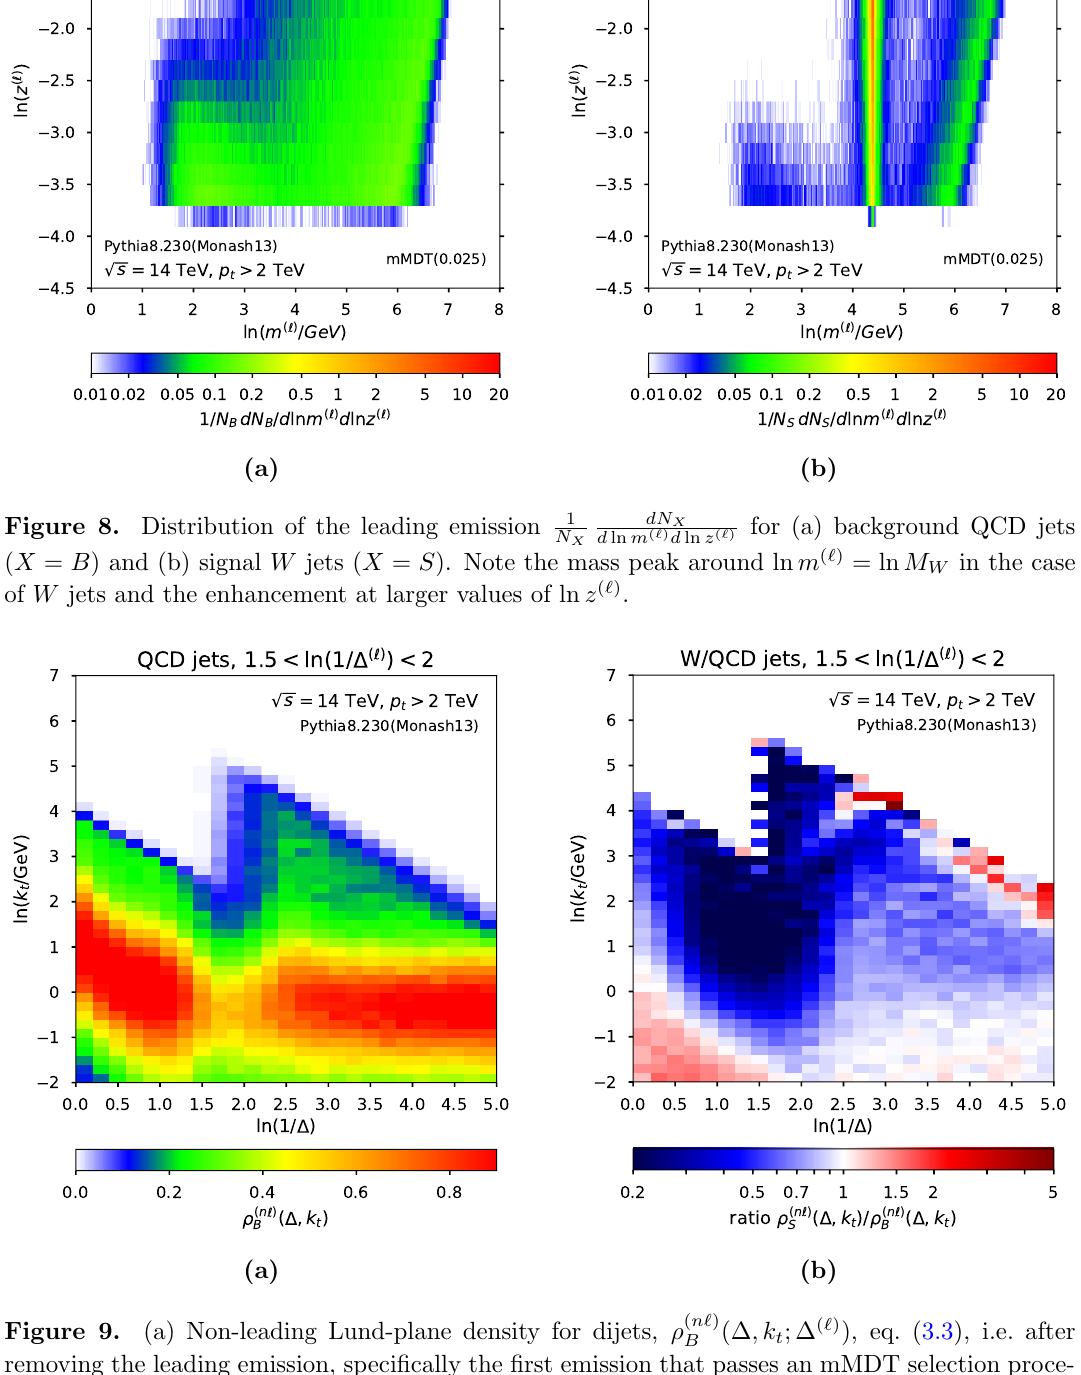
Figure 9. (a) Non-leading Lund-plane density for dijets, (cid:26) ( n‘ ) ((cid:1) ; k t ; (cid:1) ( ‘ ) ), eq. (3.3), i.e. after B removing the leading emission, speci(cid:12)cally the (cid:12)rst emission that passes an mMDT selection proce- dure. (b) Ratio of the W to QCD Lund-plane (cid:26) ( n‘ ) ((cid:1) ; k t ; (cid:1) ( ‘ ) ) densities, whose logarithm is equal S;B to the likelihood function L n‘ of eq. (3.2). Both plots correspond to the choice 1 : 5 < ln 1 = (cid:1) ( ‘ ) <